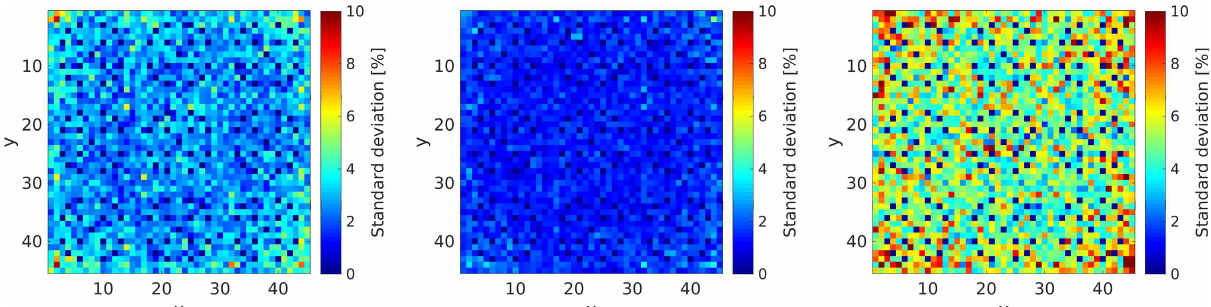
Fig. 11. Relative errors of the nodewise power estimates in percent for the lowest (left), central (middle), and topmost (right)